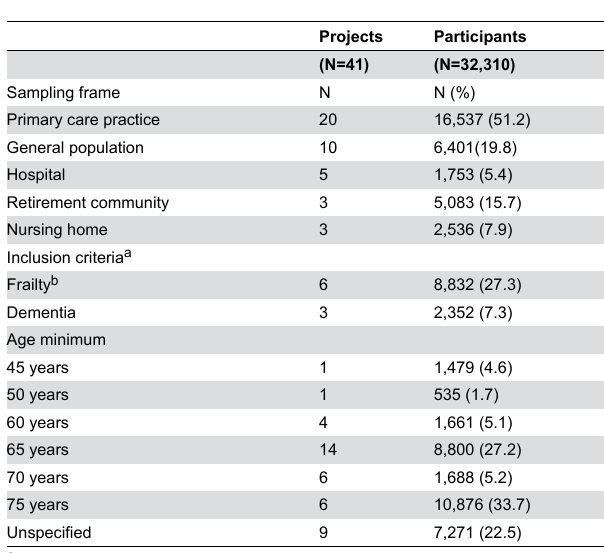
Table 1. Characteristics of 41 projects included in The Older Persons and Informal Caregivers Minimal DataSet, Netherlands,